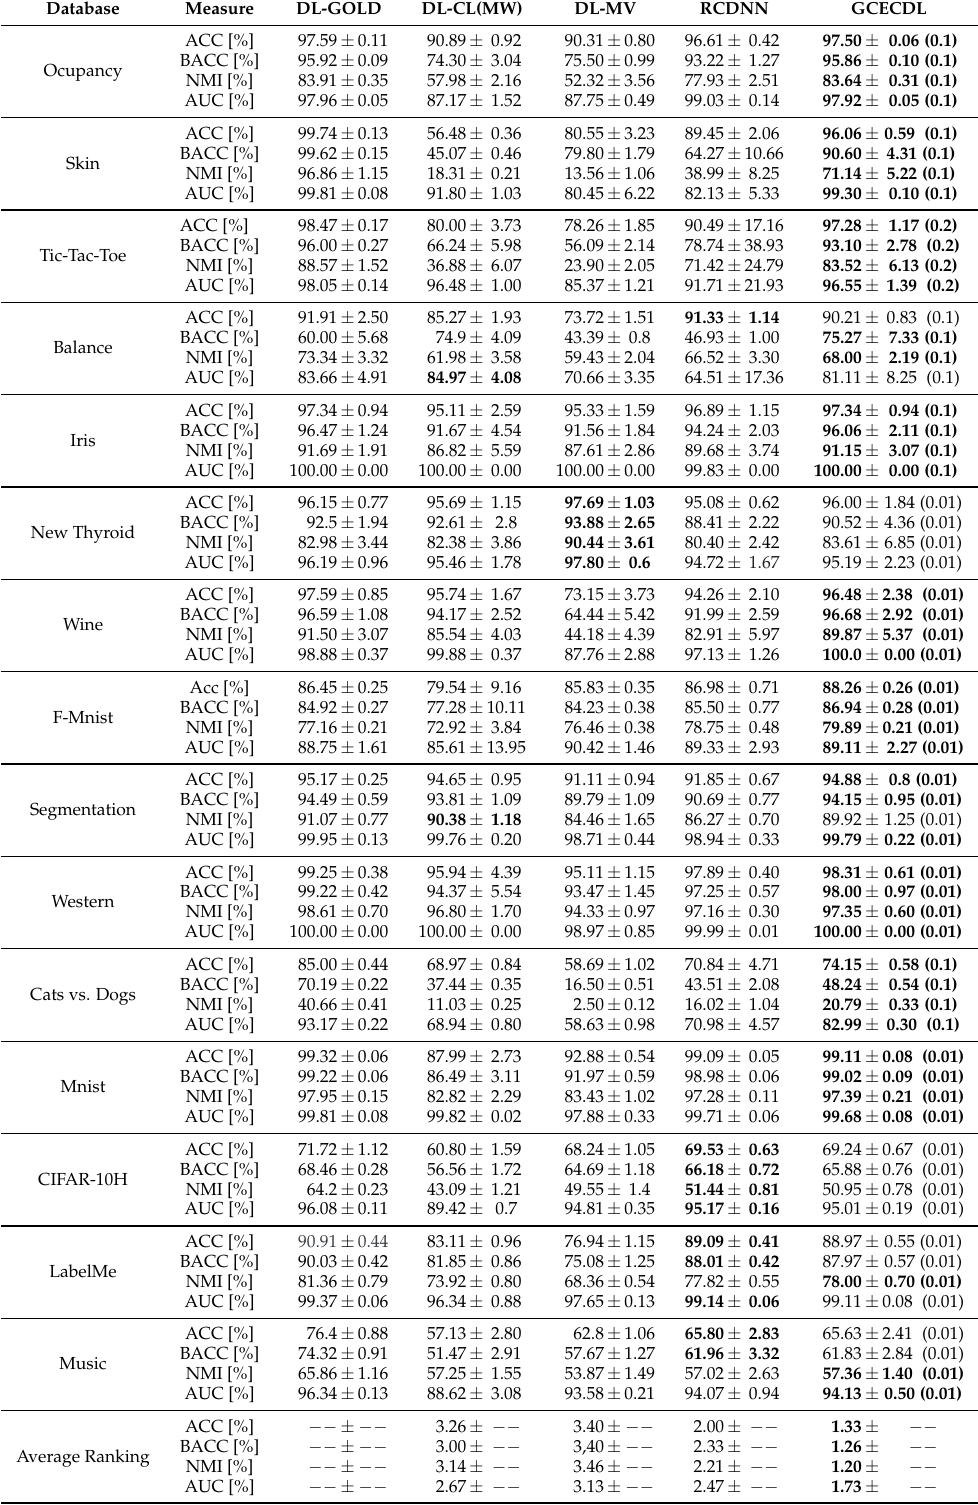
Table 3. Method comparison results—multiple-annotator classification. Bold: the highest score for each measure excluding the upper bound (target) classifier DL-GOLD. For our GCECDL, the fixed q-value is presented in parentheses. Friedman test: we obtain a Chi-square of 27.08, 23.48, 28.03, and 7.92 ( p -value = 5.6 × 10 − 6 , 3.56 × 10 − 6 , 3.20 × 10 − 5 , and 0.047) for ACC, BACC, NMI, and AUC measures,